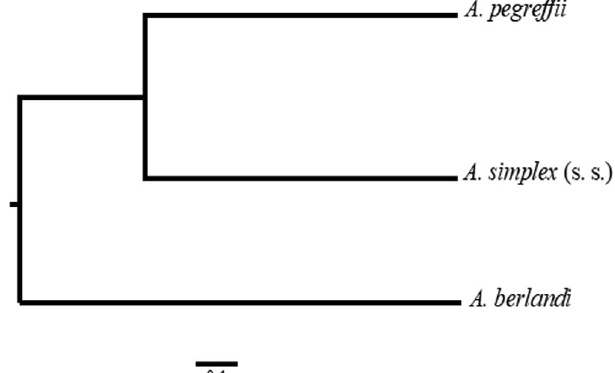
Figure 3. Unweighted pair group method of analysis (UPGMA) cluster based on Nei ’ s genetic distance values, inferred from allelic frequencies calculated at fi ve microsatellite loci (i.e. Anisl 10535, Anisl 05784, Anisl 00875, Anisl 08059 and Anisl 7 ), showing the genetic relationship between A. berlandi and the other two members of the A. simplex (s. l.) complex (based on the allele frequencies found, on average, at the same loci in A. pegref fi i and A. simplex (s. s.) in our previous analysis